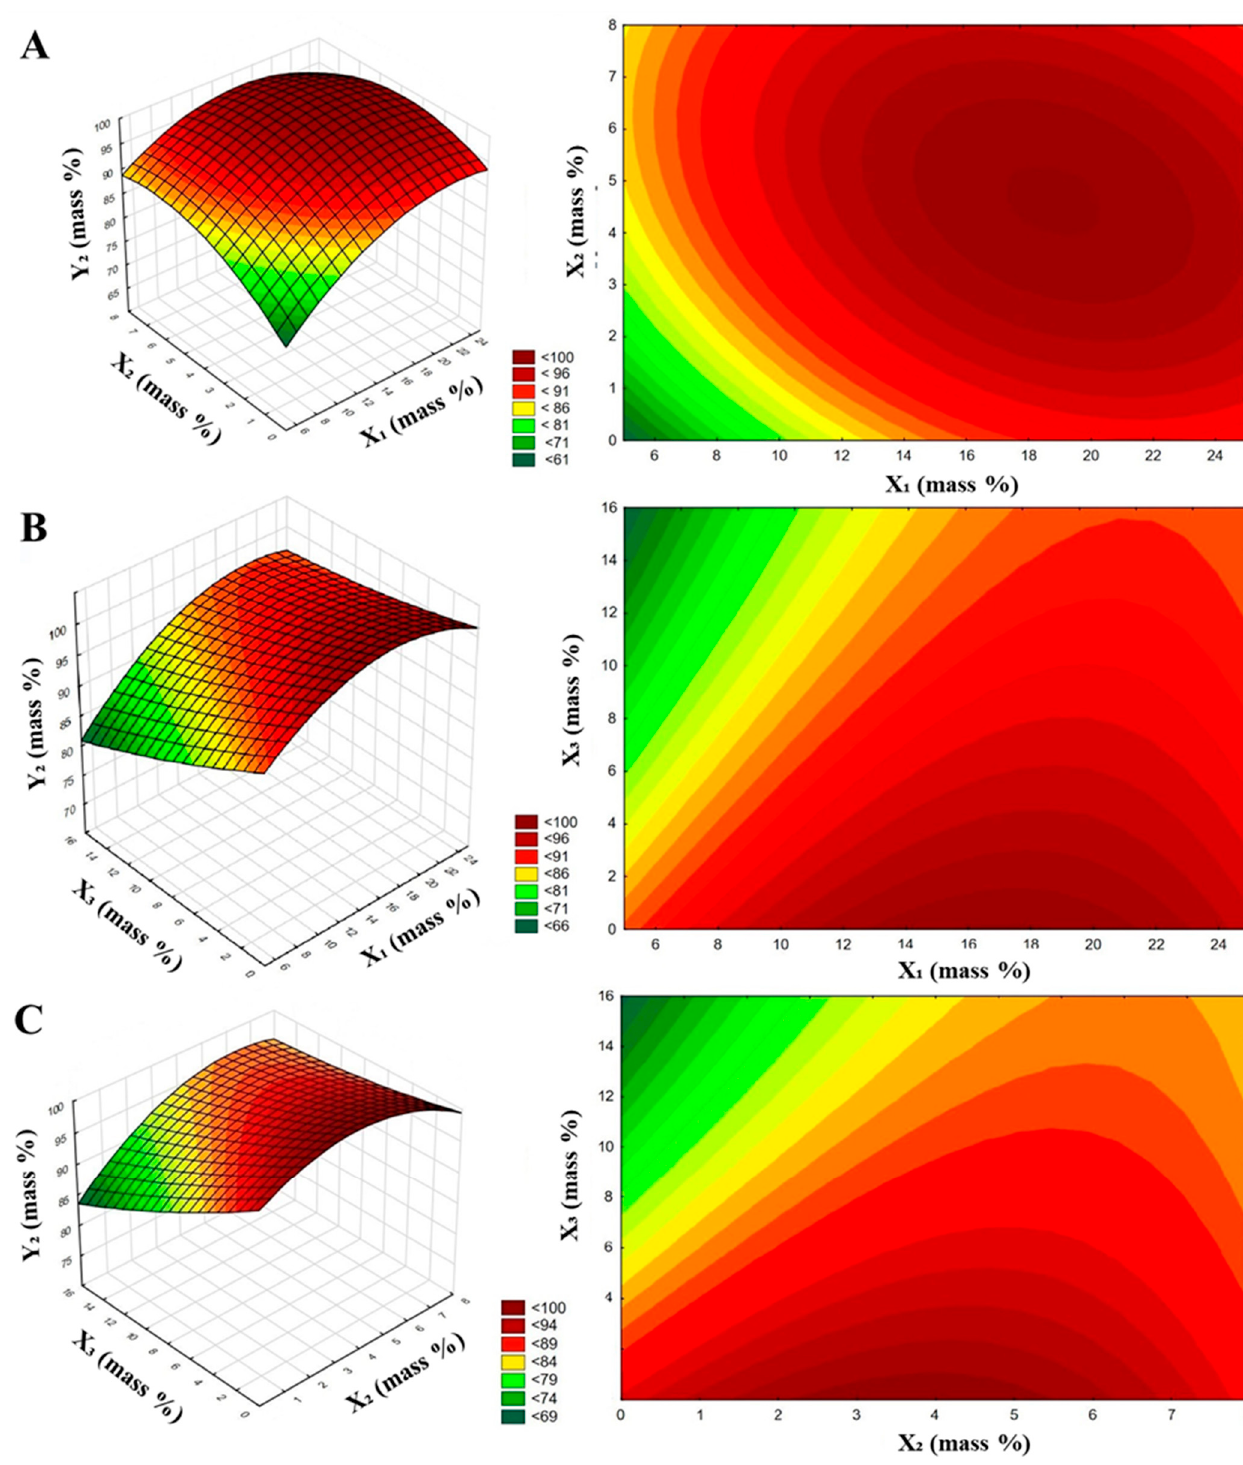
Figure 3. Response surface charts with contour plots representing the influence of the composition of coating agents on the effectiveness of caking prevention in fertilizers at 30 days of storage: ( A ) effect of fatty amine and stearic acid contents; ( B ) effect of fatty amine and surfactant contents; and ( C ) effect of stearic acid and surfactant contents.